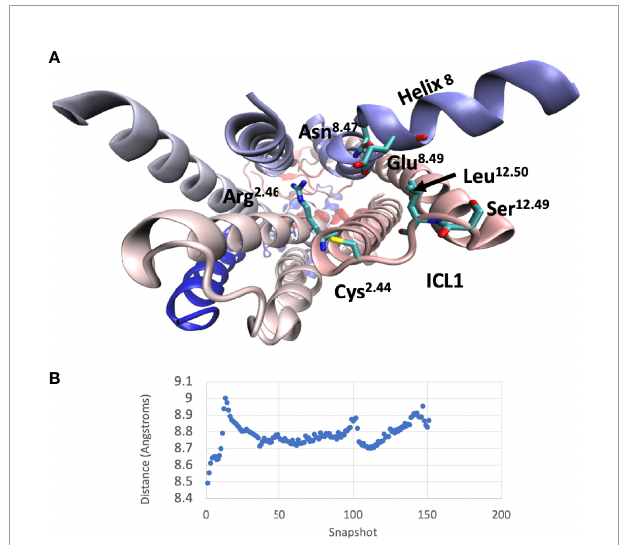
FIGURE 8 | Interactions of ICL1 during a molecular dynamics simulation of CLR. (A) Cytoplasmic view of CLR showing the main sidechains involved in interactions with ICL1. (B) Variation of the minimum distances between the centres of mass of L169-E390 during the molecular dynamics